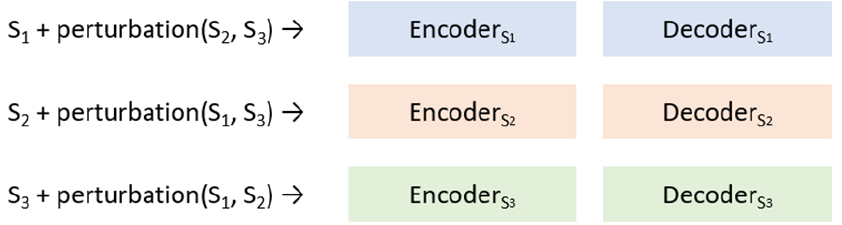
Figure 4. Three autoencoders in branch 1.